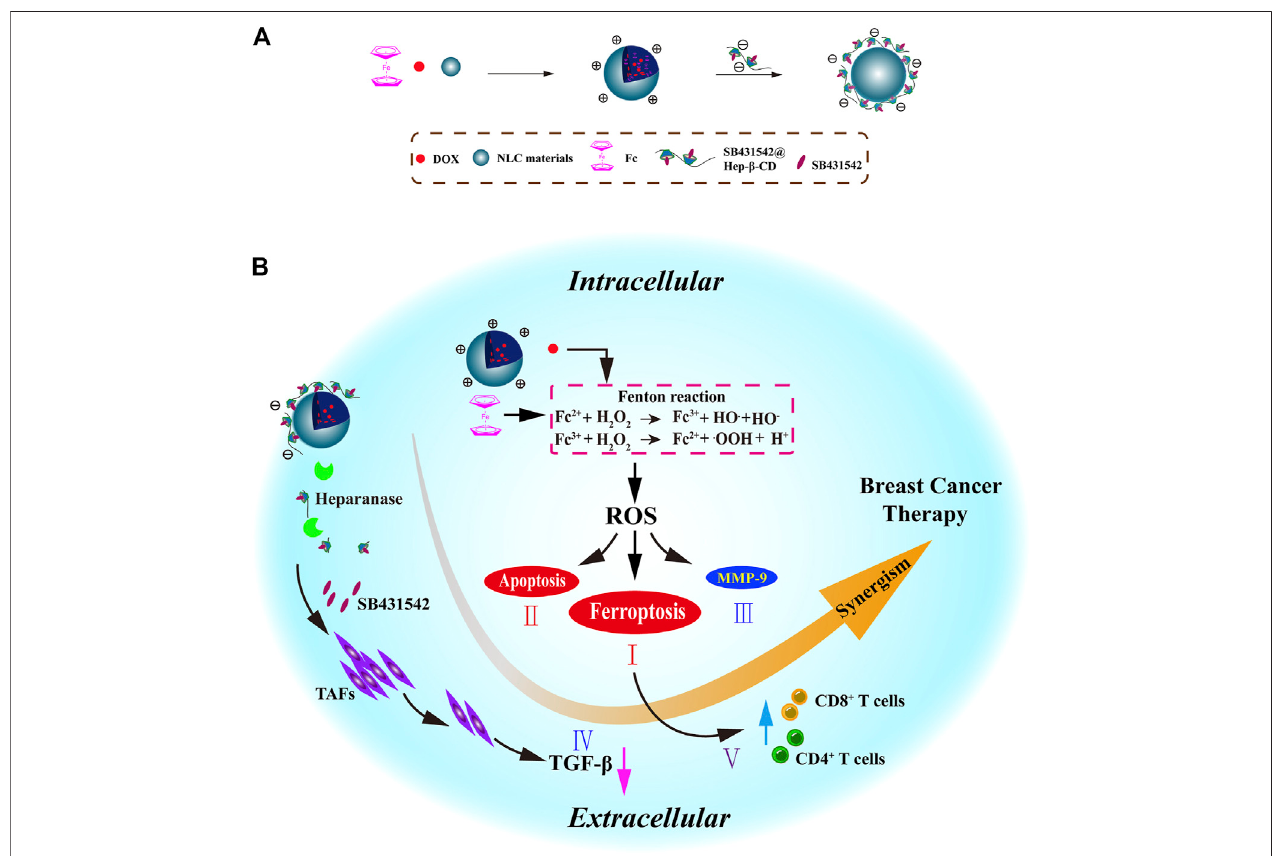
FIGURE 9 | (A) Synthesis scheme of NLC/H (DOX + Fc + SB431542) NPs. (B) Mechanism of NLC/H (DOX + Fc + SB431542) NPs for breast cancer therapy. Adapted from Zhang et al., (2021) Copyright @ 2021 (Elsevier).